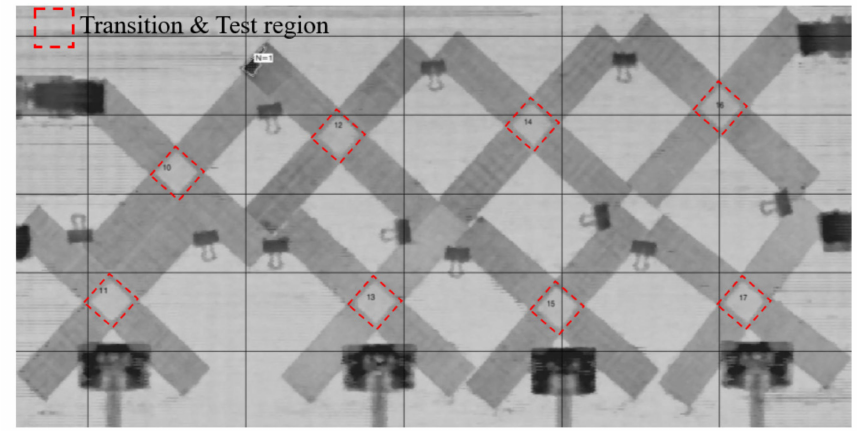
Figure 7. Ultrasonic C-scan results of the manufactured cruciform specimens.